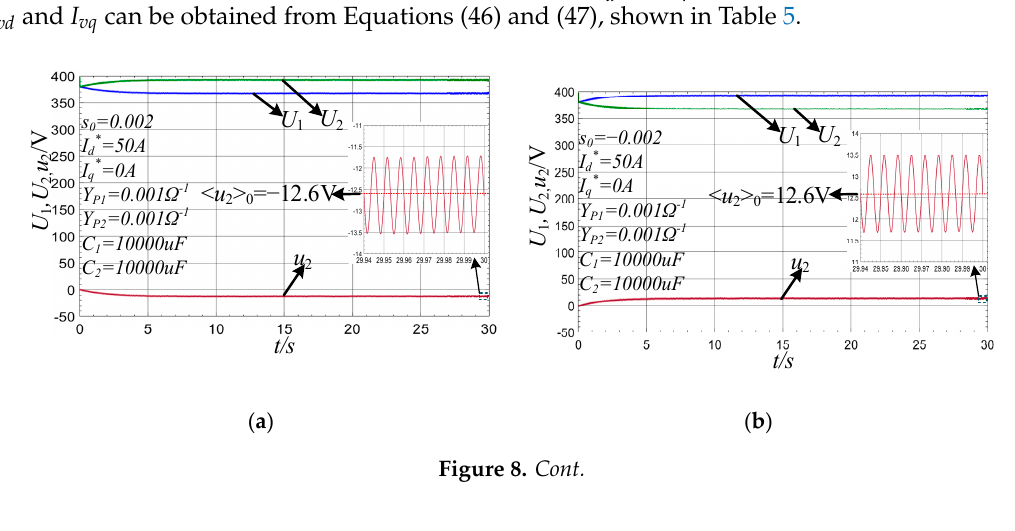
Figure 7. Waveforms of 𝑢 (cid:3028) , 𝑖 (cid:3028)∗ , and 𝑖 (cid:3028) .